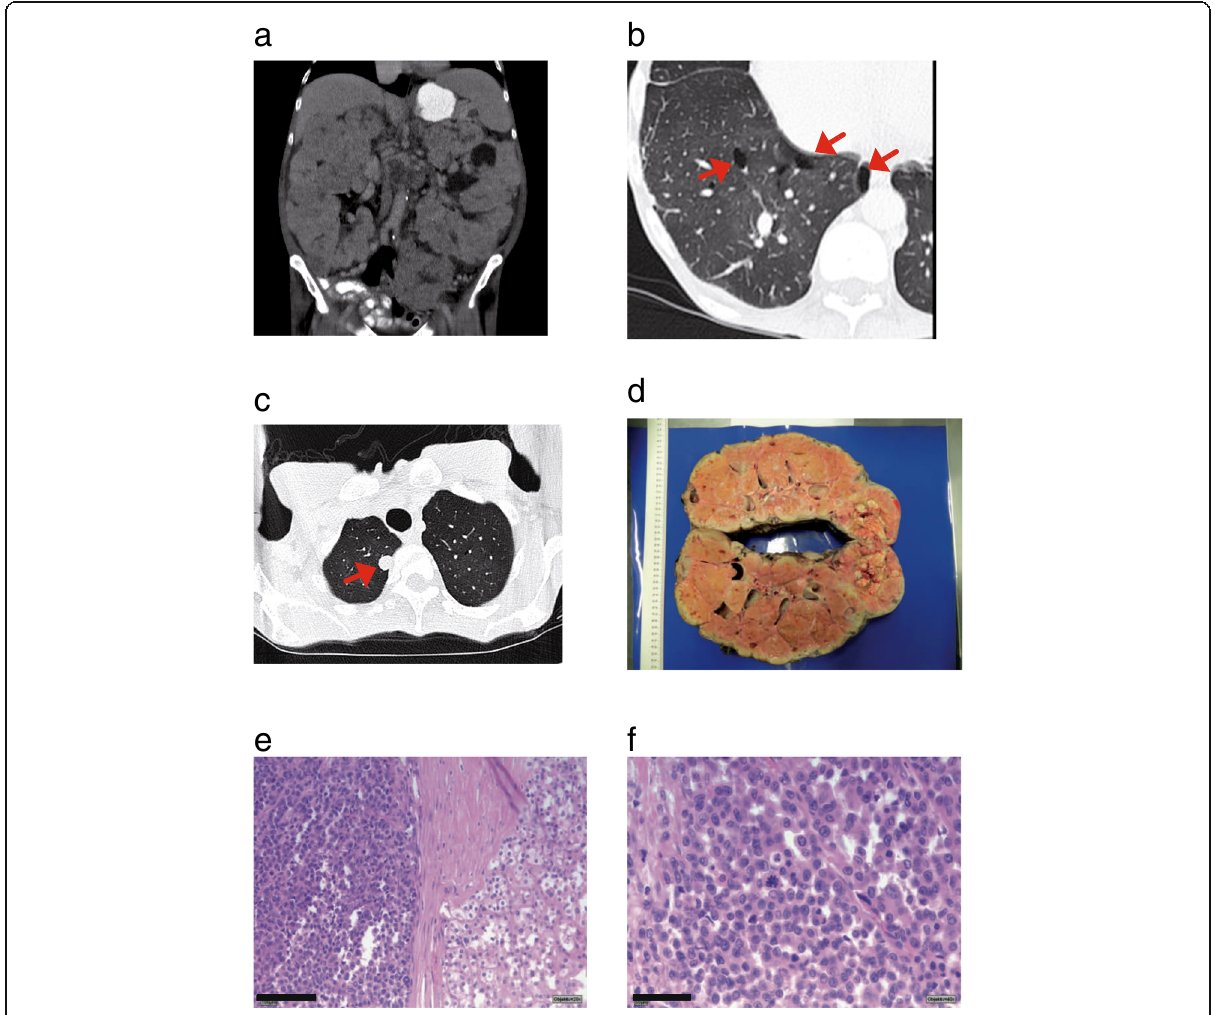
Fig. 1 CT imaging of the patient and macroscopic and histopathological analysis of the kidney tumor tissue a CT scan of the abdomen shows massive enlarged kidneys with bilateral tumorous lesions. b and c CT scan of the thorax reveals numerous pulmonary cysts ( b , red arrows ) and several pulmonary lesions suspicious for metastastic disease ( c , red arrow ). d Macroscopic picture of the left kidney shows that the whole organ is interspersed with nodular tumors. e Beside the nodular growing chromophobe carcinoma (right side) a second tumor component consisting of very small tumor cells can be detected (left side of the panel, bar = 100 μ m). f these small tumors cells show nuclear pleomorphism with increased and atypical mitosis (bar = 50 μ